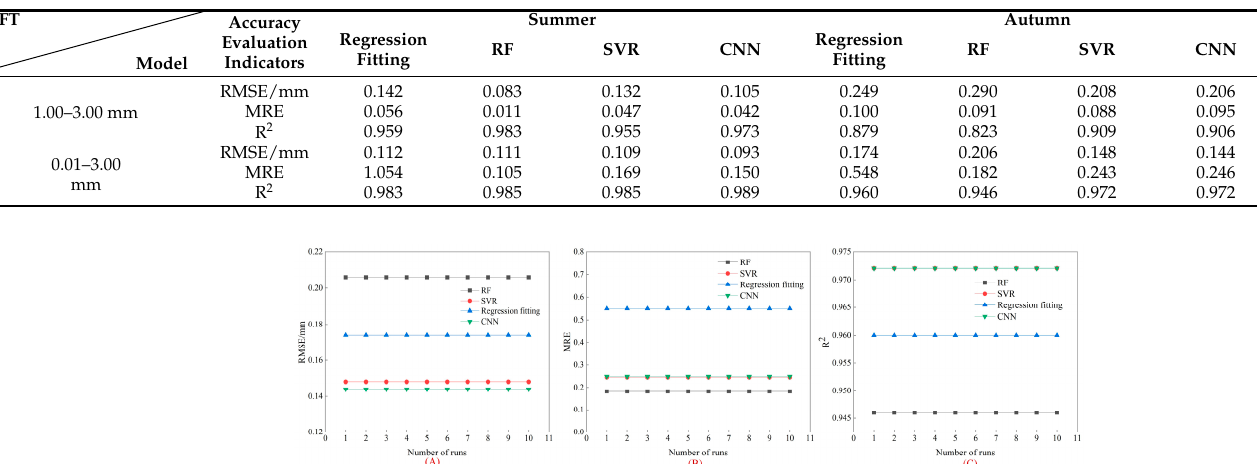
Table 2. Model inversion accuracy evaluation.